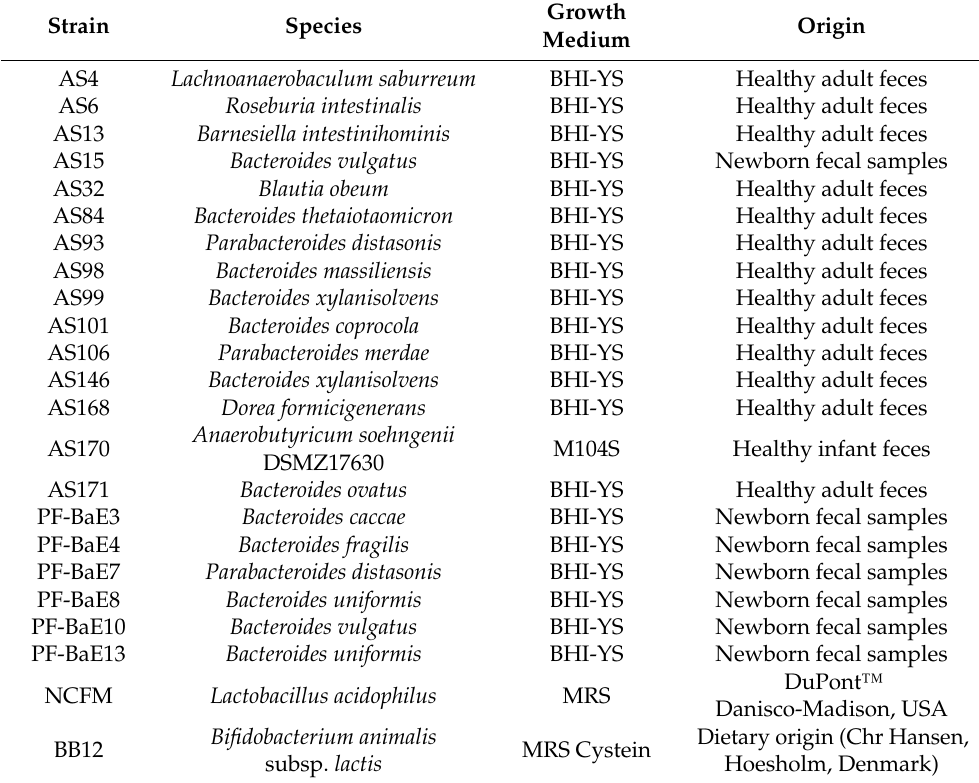
Table 1. Bacterial strains and growth